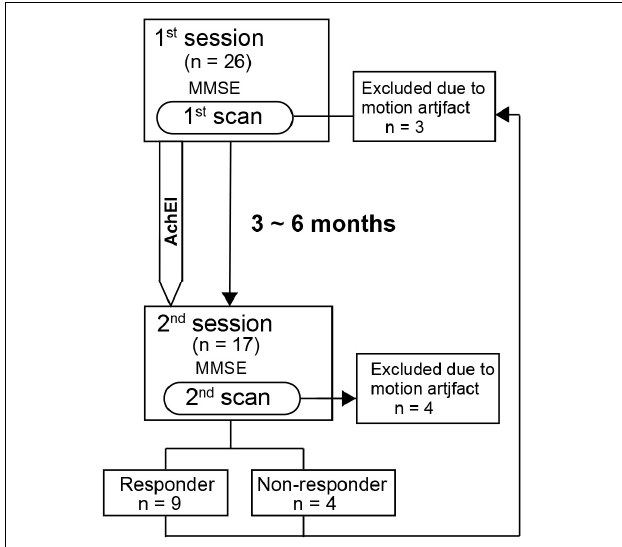
FIGURE 1 | Time schedule for the detection of resting-state network changes following acetylcholinesterase inhibitor therapy in patients with Alzheimer’s